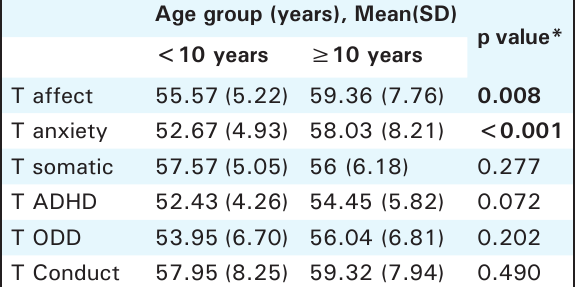
Table 4. Distribution of T scores by age group (years).